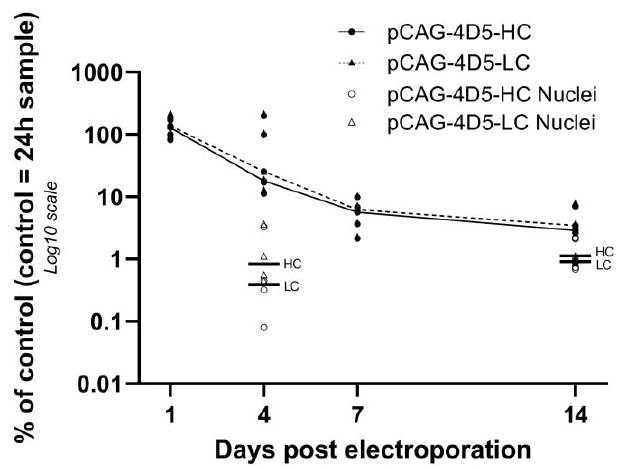
Figure 6. (Intranuclear) pDNA quantification . Balb/c mice received intramuscular pDNA electro- transfer of 60 µg pDNA (equimolar mixture pCAG-4D5-HC and pCAG-4D5-LC) in the tibialis an- terior muscle. Muscles were isolated at multiple time points, nuclei were isolated, and DNA was extracted and quantified using qPCR. pDNA quantification ( : intranuclear pCAG-4D5-HC, : in- tranuclear pCAG-4D5-LC, : pCAG-4D5-HC whole muscle, : pCAG-4D5-LC whole muscle) was performed relative to the amount of the control subject at 24 h. Data are represented as individual data points per animal (average of triplicate). Curves represent the median per time point (line: pCAG-4D5-HC, dashed line: pCAG-4D5-LC) ( n = 5, five mice per time point) for whole-muscle pDNA quantification, horizontal lines represent median intranuclear pDNA levels (day 4: n = 4; week 2: n = 5).